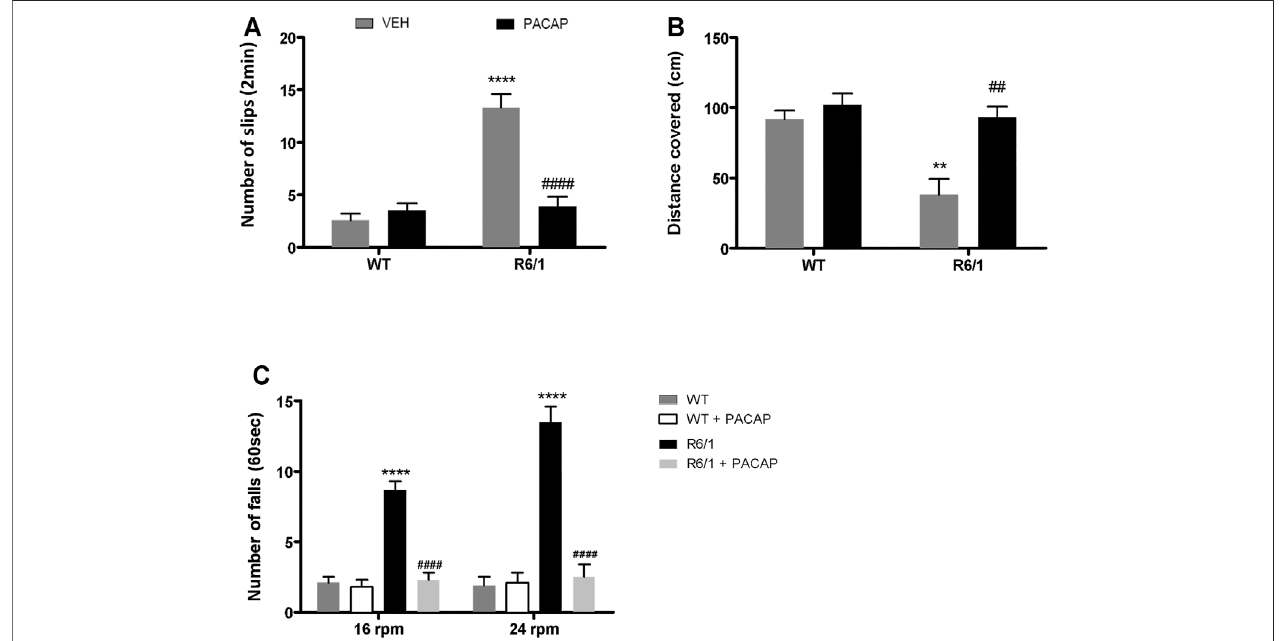
FIGURE 10 | PACAP administration decreases motor de fi cits in R6/1 mice. At 18 weeks of age, WT and R6/1 mice were daily intranasally administrated with vehicle (VEH) or PACAP (30 μ g/kg/day). The following measurements were recorded after 7 days of treatment: (A) number of slips and (B) distance covered using the balance beam task; (C) number of falls recorded in the rotarod test. Results are expressed as mean ± SEM ( n (cid:1) 7/group). Data were analyzed by two-way ANOVA followedbyBonferroniaspost-hoctest.** p < 0.01and**** p < 0.001ascomparedtoVEH-WTand## p < 0.01and#### p < 0.001ascomparedtoVEH-R6/1mice.